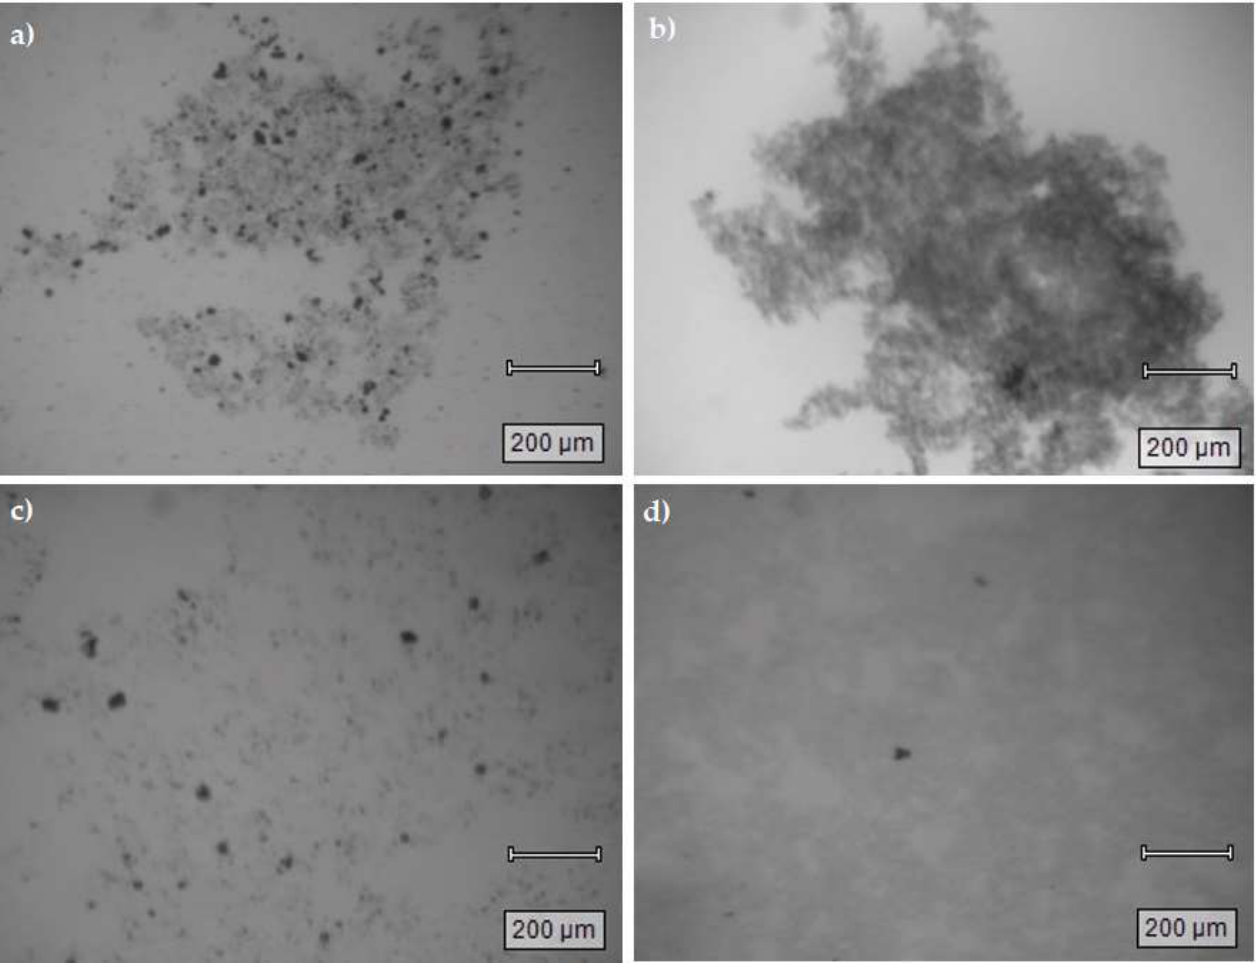
Figure 6. Floc sample images (5 × magnification) obtained for variable coagulant systems: ( a ) PNP with lab water and ferric sulfate; ( b ) PNP with river water and ferric sulfate; ( c ) PNP with lab water and aluminum sulfate; ( d ) PNP with river water and aluminum